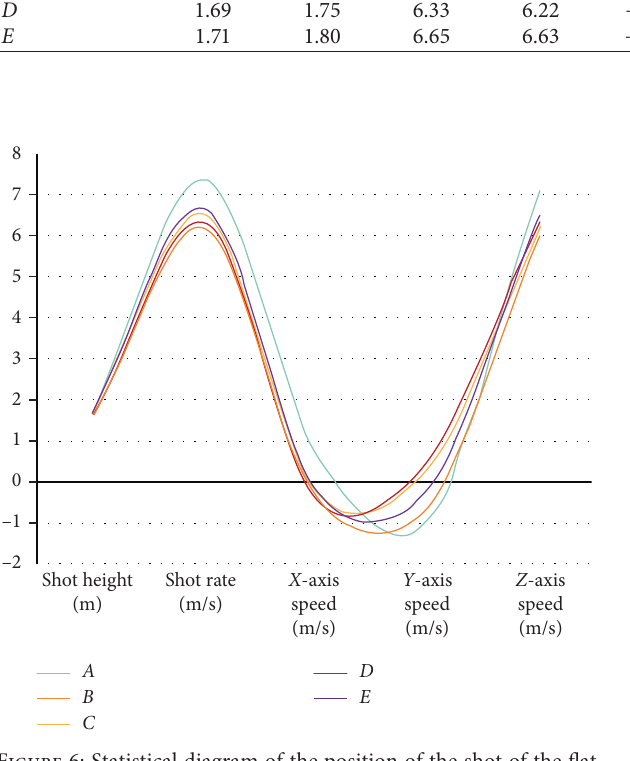
Figure 6: Statistical diagram of the position of the shot of the flat strike.